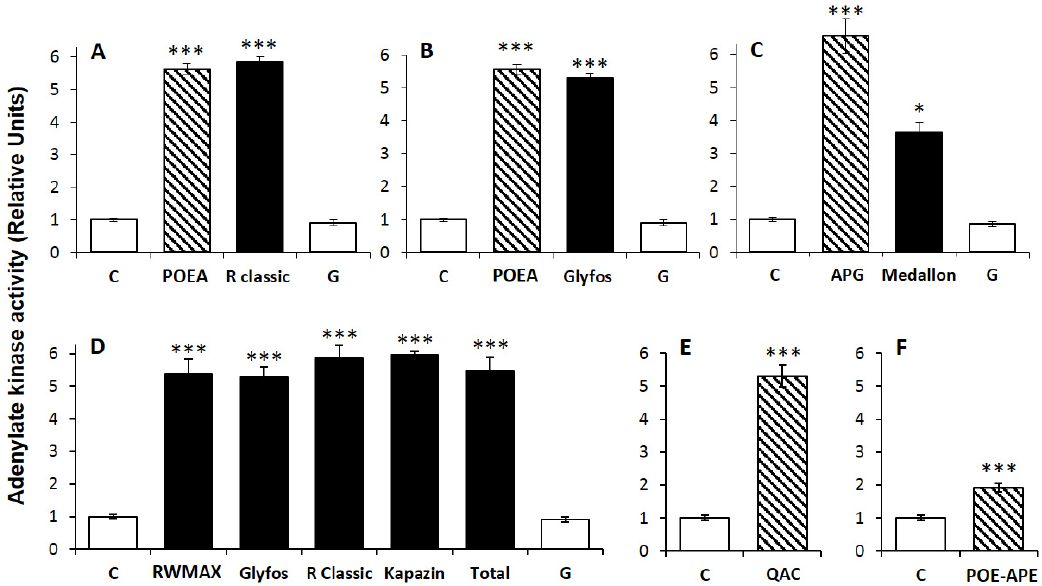
Figure 3. Membrane integrity disruption by formulations and co-formulants. * p < 0.05, ** p < 0.01, *** p < 0.001. ( A ) 100 ppm of Glyfos is compared to the content in POEA (10 ppm) and G (48.6 ppm); ( B ) 100 ppm of Glyfos is compared to the content in POEA (10 ppm) and G (48.6 ppm); ( C ) 2000 ppm of Medallon is compared to the content in APG (800 ppm) and G (975 ppm); ( D ) 100 ppm of the formulations are compared to the content in G (48.6 ppm); Two co-formulants were also tested around their LC 50 (see Table 1): ( E ) QAC, 58 ppm; ( F ) POE-APE, 222 ppm.